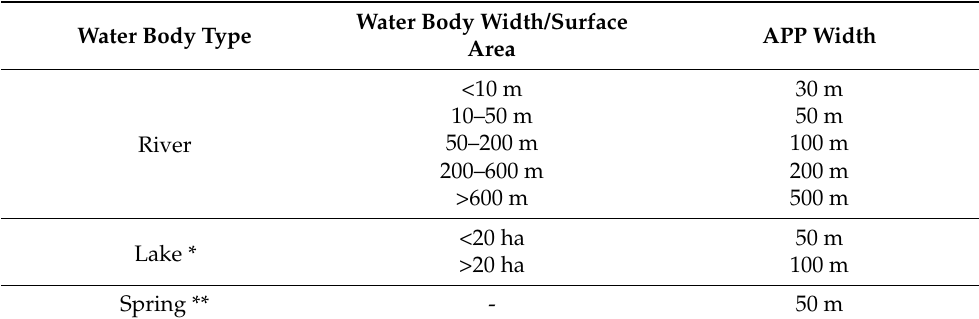
Table 2. Water body type and width and the corresponding mandatory hydric permanent preserva- tion area (APP)